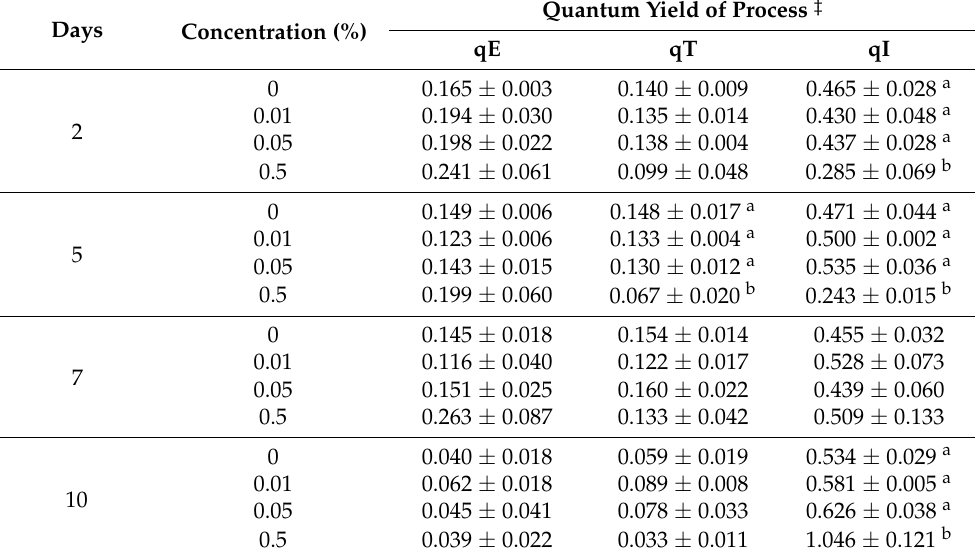
Table 2: Quantum yield of the photoprotective pathways of apple trees “Top Red” on the background of Brevis ® inhibitor gradient with time. Each value is an average of three biological repeats performed in duplicates, and the error values are standard error of the mean. Letter notation describe statistically significant difference at p <